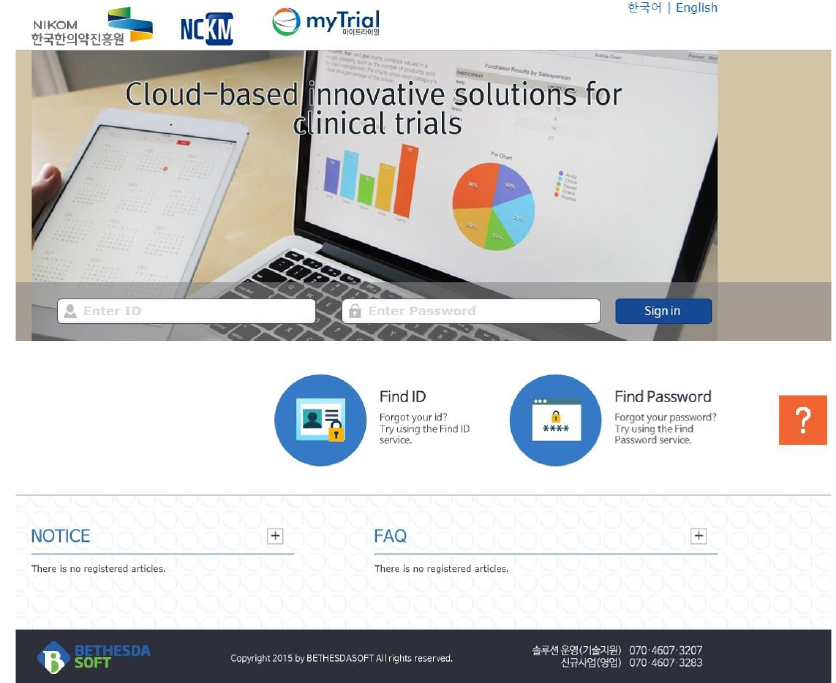
Figure 2. Data collection platform of the WECORE-KOM. The main page of the electronic data cap- ture system is operated by the INKOM under the Ministry of Health and Welfare of Korea (accessed 20 July 2022). INKOM, National Agency for Korean Medicine Innovative Technologies Development; WECORE-KOM, Weight Control Registry using Korean Medicine.